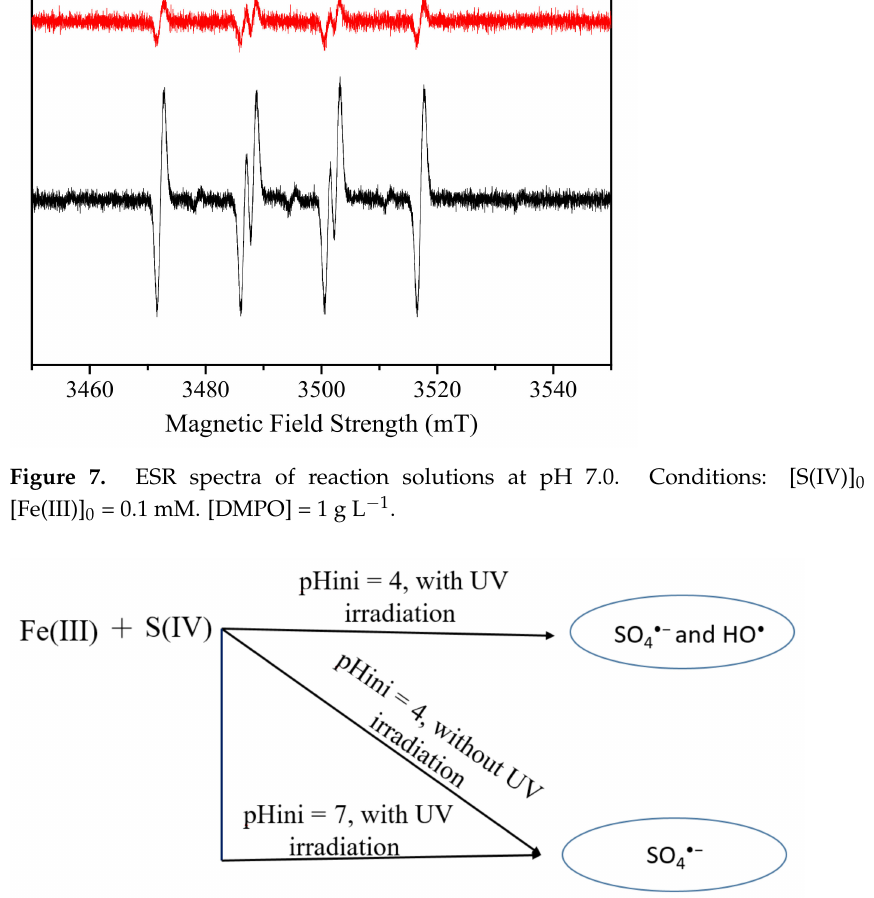
Scheme 1. Proposed mechanism in the Fe(III)/S(IV) system at pH 4.0 and 7.0 under dark and UVA